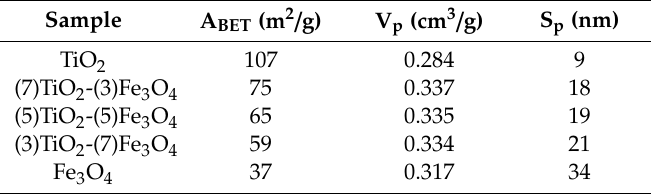
Table3. ParametersoftheporousstructurefortheobtainedTiO 2 -Fe 3 O 4 materialsandreferencesamples.